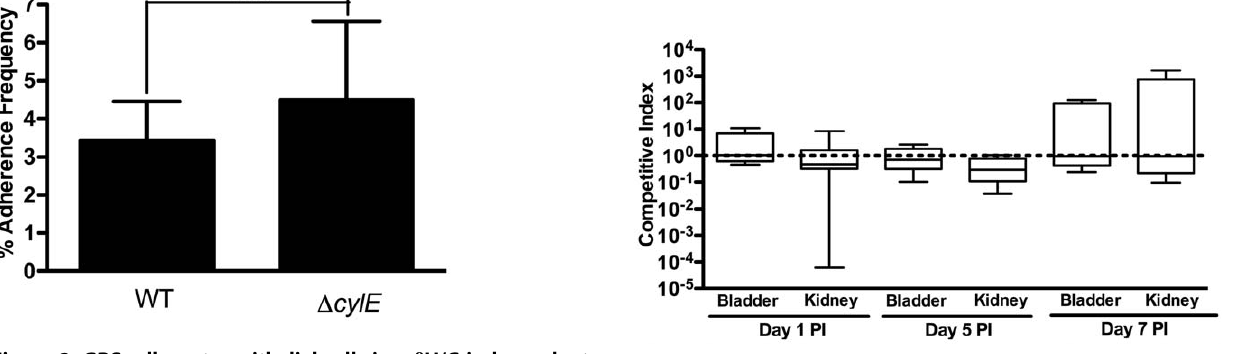
Figure 4. No fitness advantage of b H/C-sufficient GBS during UTI at early or late time points. Competition assays were performed using WT and D cylE GBS and revealed competitive indices near 1, indicating an absence of fitness differences, at 1 and 5 days post- infection.